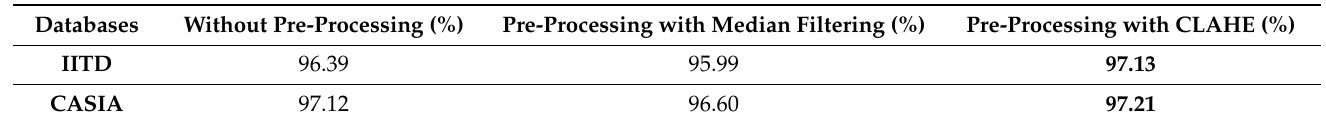
Table 6. The performance of our system without and with pre-processing (median filtering or CLAHE) using the IITD and CASIA